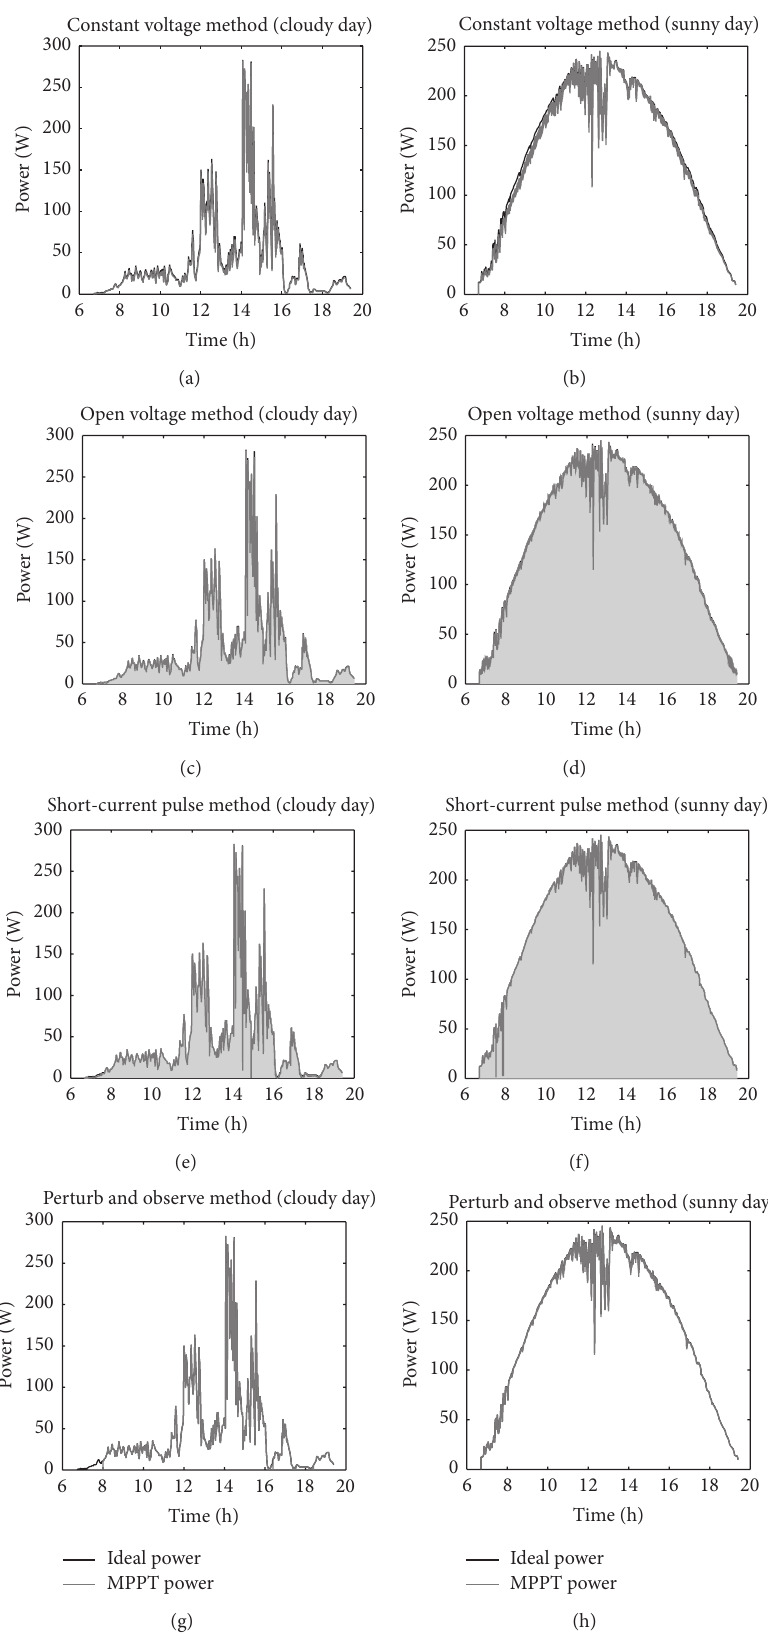
Figure 13: Power produced by YL280C-30b monocrystalline solar panel calculated with the studied MPPT methods, for ambient conditions measured at the Goddard Space Flight Center (GSFC) on May 13, 1971 (cloudy day), and May 14, 1971 (sunny day). Maximum extractable power (ideal) has been also